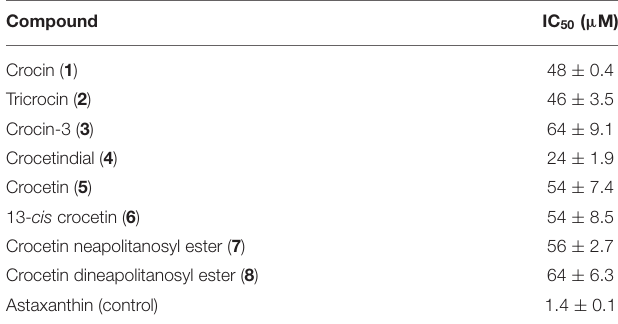
TABLE 3 | 1 O 2 -quenching activities of apocarotenoids and